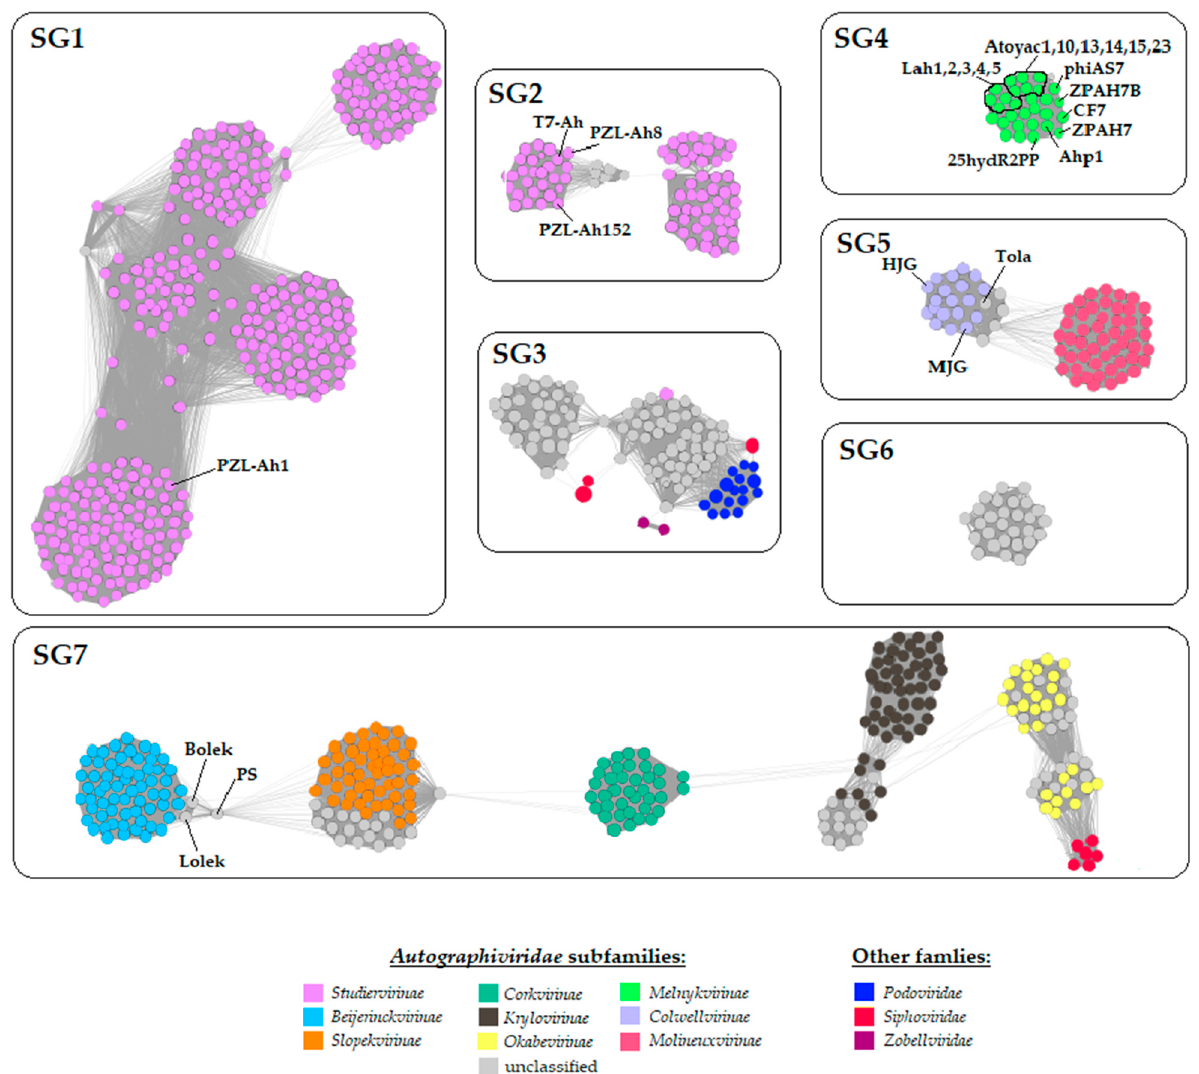
Figure 5. Protein-based phage similarity network. Each circle (node) represents a genome and connecting lines (edges) represent the similarity between genomes based on shared clusters of proteins. Only Autographiviridae family members and phages of other families demonstrating significant similarity to them are shown. Bolek, Lolek, Tola, and other Aeromonas phages are indicated with black lines and names. The coloring of the nodes (according to the key) is based on the current taxonomic classification of the phage, that is, subfamilies of Autographiviridae members and families of other phages. The edge thickness reflects the degree of similarity between two phages (the thicker the edge, the higher the similarity), considered as an overall similarity of proteins encoded by a pair of phages.